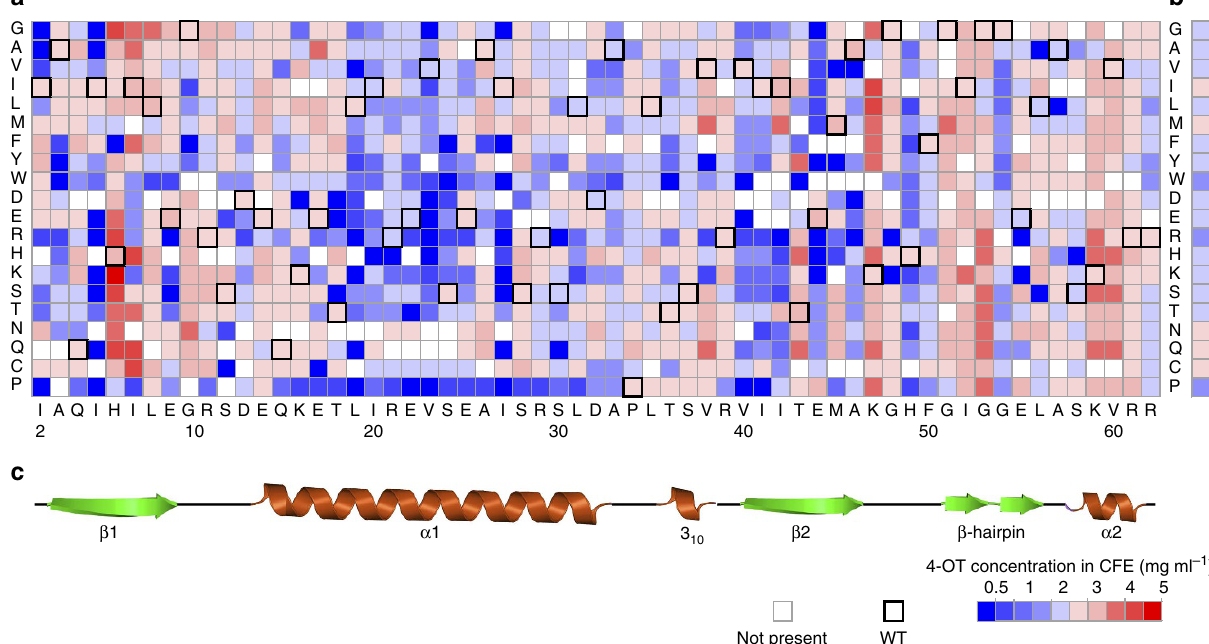
Figure 2 | Mutability landscape of 4-OT for protein expression. ( a ) The horizontal axis of the data matrix depicts the wild-type sequence of 4-OTand the vertical axis depicts the 20 possible amino acid residues. The wild-type amino acid residue at each position is indicated by bold squares and white boxes represent mutants that are not present in the collection. The colour indicates the concentration of soluble 4-OT variants in CFE in mgml (cid:2) 1 , which was determined by quantitative densitometry on SDS–PAGE gels (Supplementary Fig. 1; details on this procedure can be found in the Methods section). The detection limit of this method is 0.5mgml (cid:2) 1 . The depicted data are an average of two separate experiments ( n ¼ 2). ( b ) The average effect of each amino acid substitution across the entire protein on the expression of soluble protein. ( c ) The secondary-structure elements of 4-OT 20